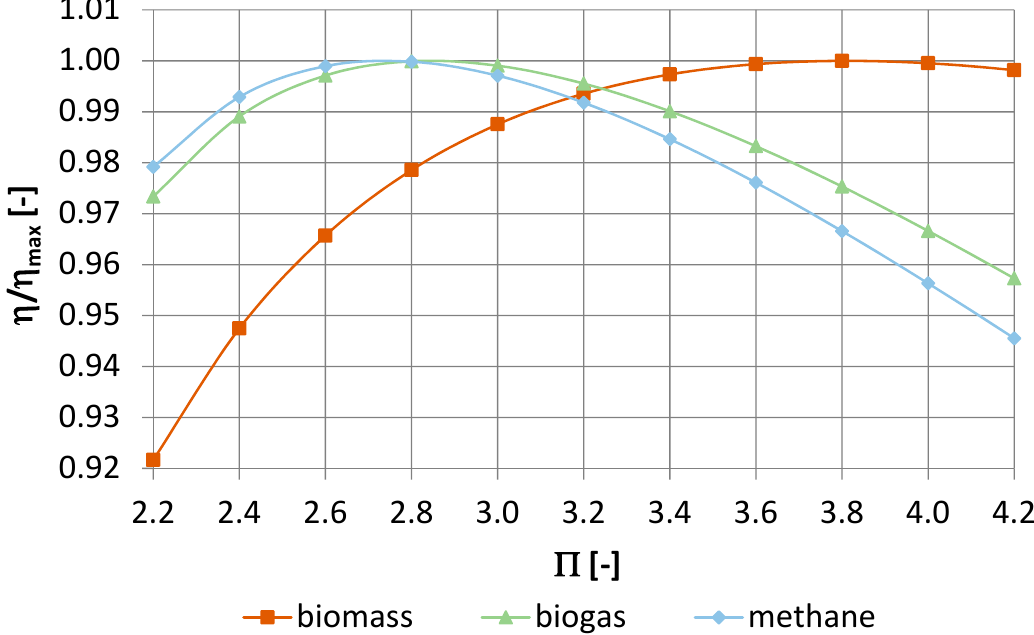
Figure 3. Effect of compression ratio ∏ on the value of relative efficiency (referred to the maximum value) for three example fuels in variant 1.